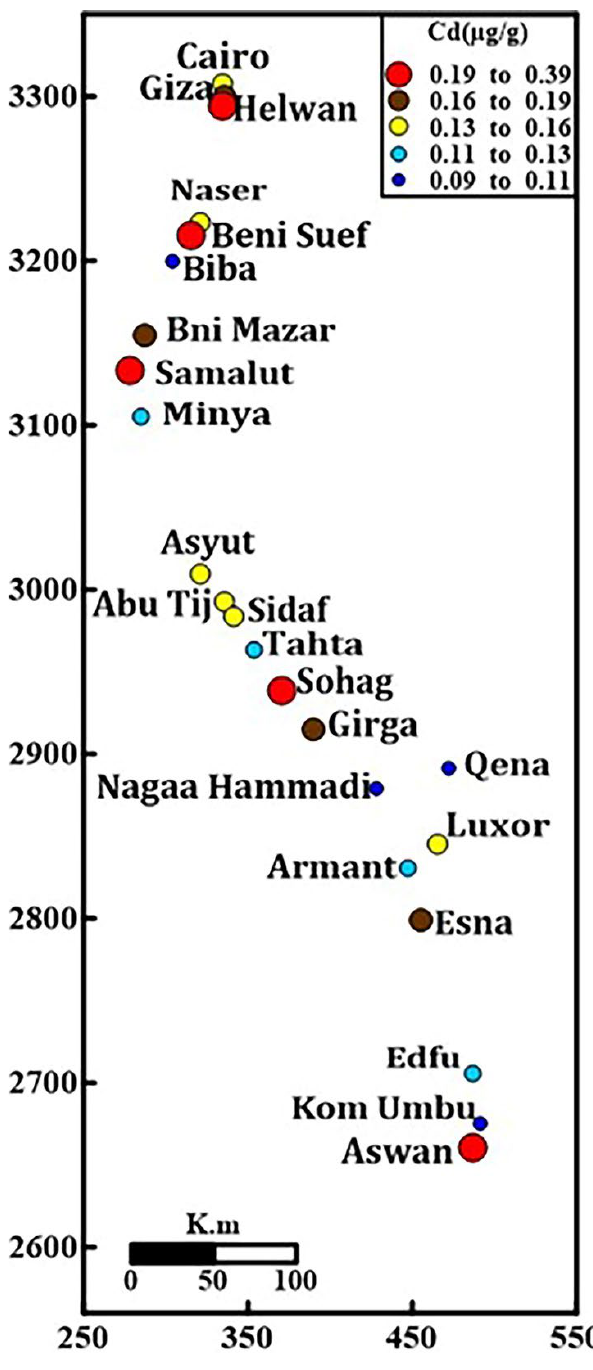
Figure 3. Symbol map of Cd concentration (mg kg − 1 ) of the Nile River mainstream sediments.